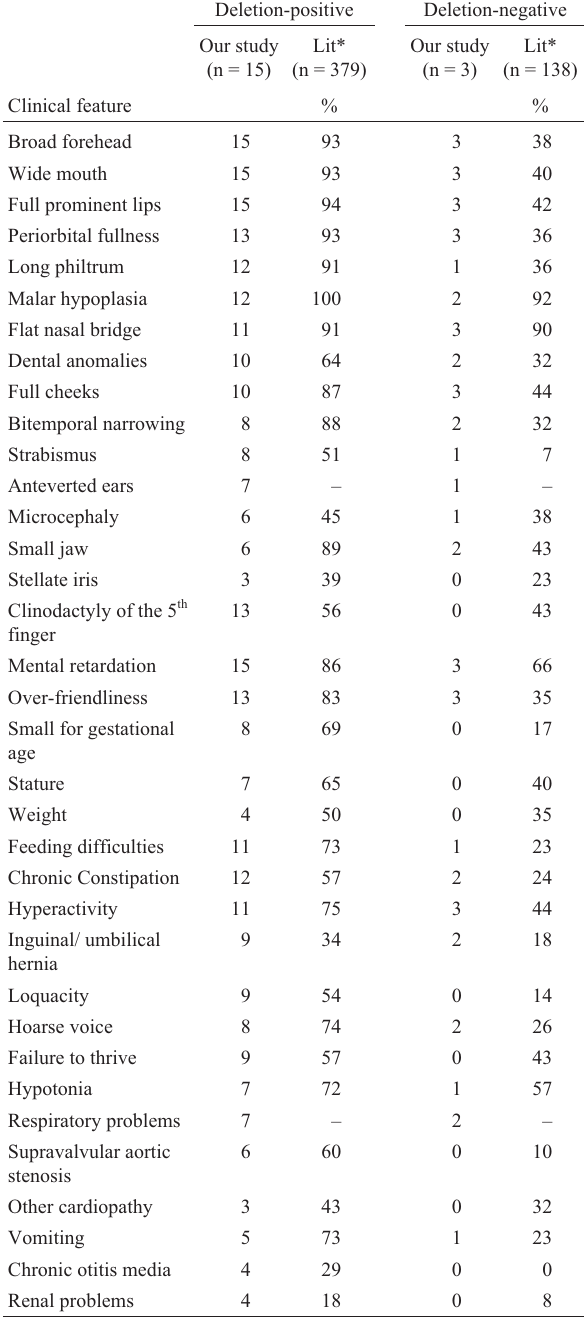
Table 1 - Clinical findings related with the Williams Beuren syndrome (WBS) children in our study with and without the 7q11.23 deletion compared with data from the